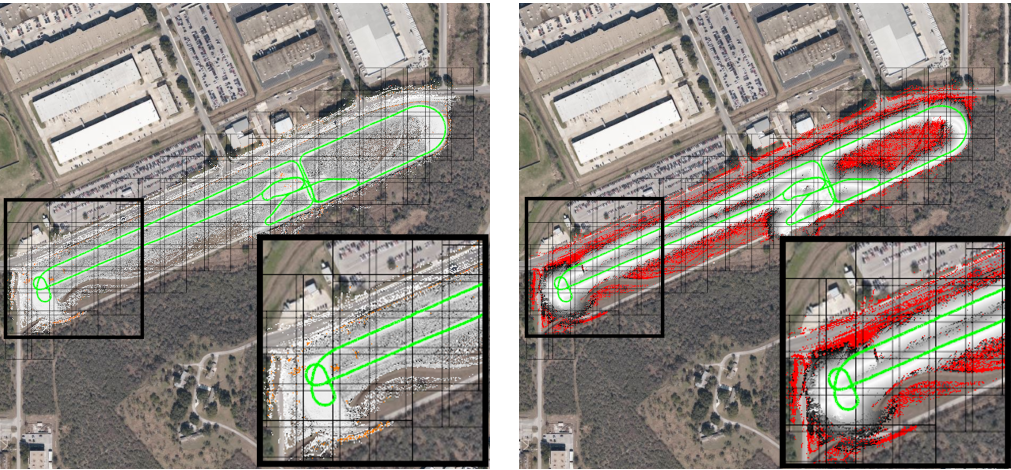
Figure 3. The persistent map (costmap layer on left, sensor distance layer on right) with GPS available through the entire map. GPS tracks are shown in green. Sensor distances over 30 m are shown in red. The insets show a zoomed-in section of the southwest corner of the track. The satellite imagery is shown only for